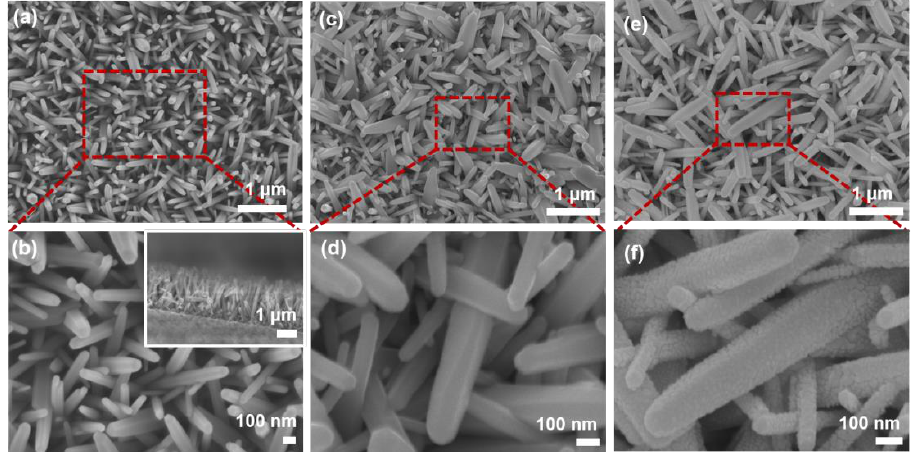
Figure 2. SEM images of ( a , b ) ZnO nanorod arrays at different magnifications, inset is the cross- sectional view of ZnO nanorod arrays; ( c , d ) ZT ; ( e , f ) ZAT .